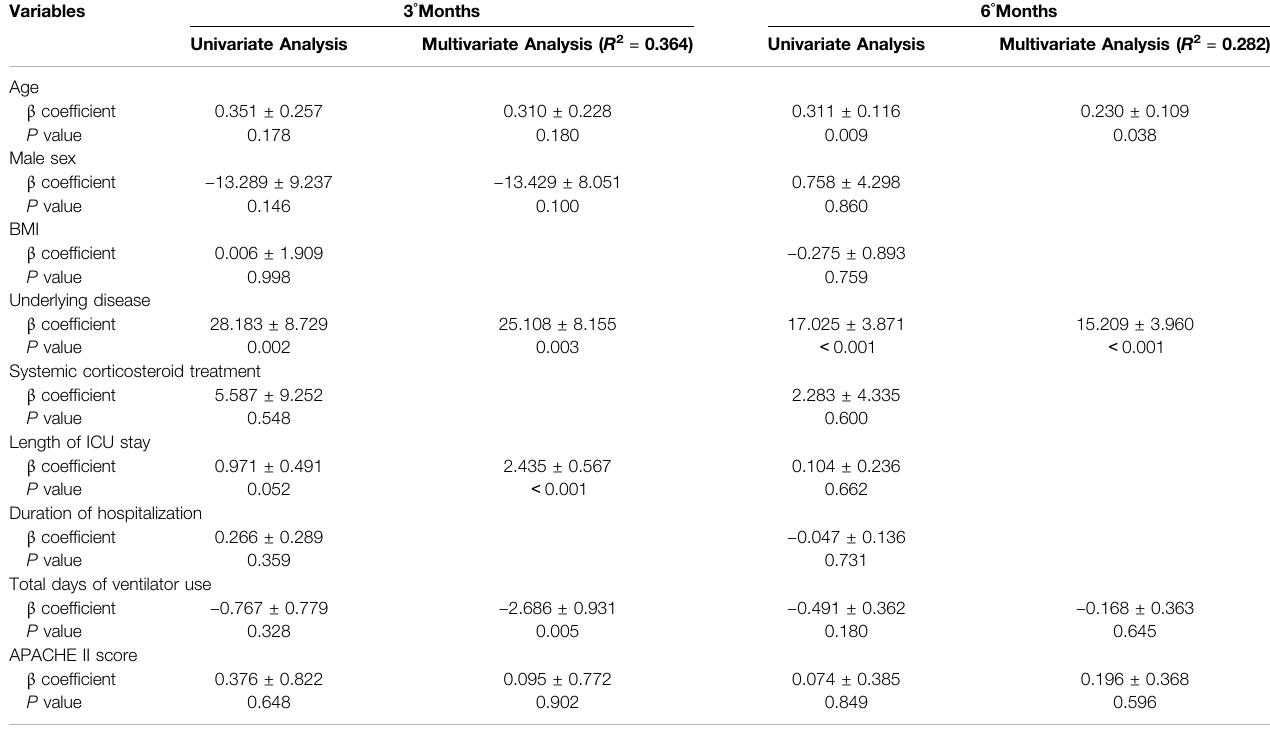
TABLE 3 | Predictors of the CT score during the fi rst 6 ° months after discharge.